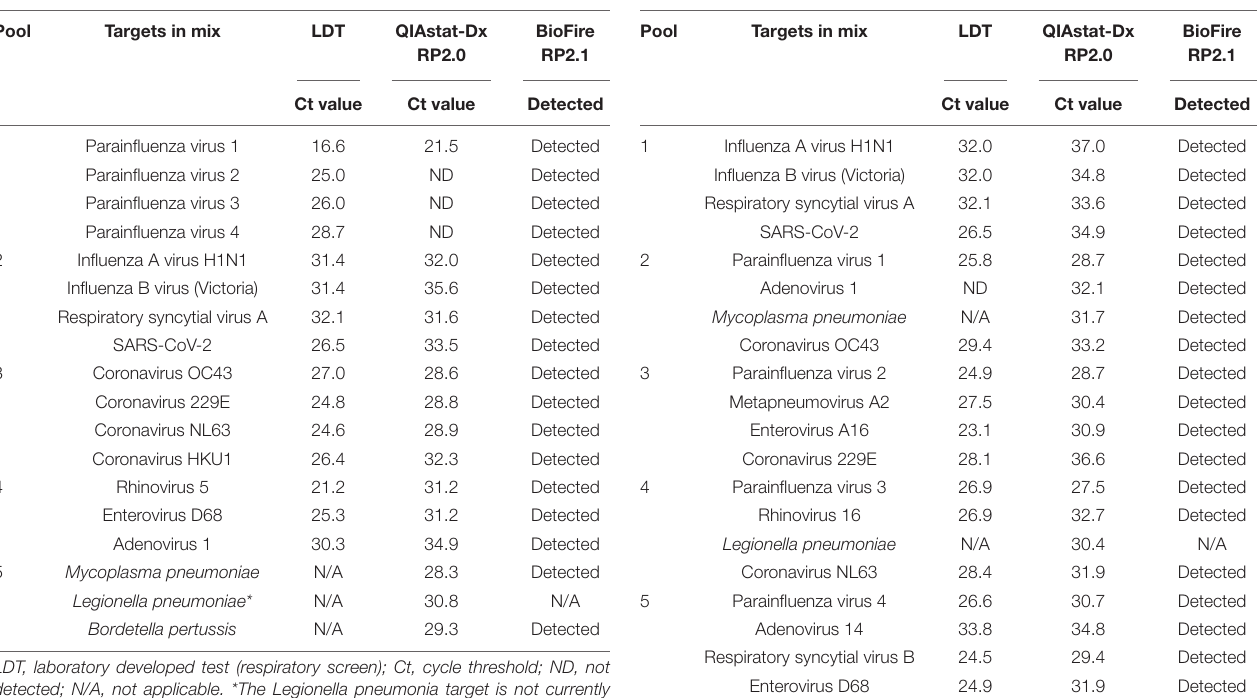
TABLE 2 | Qnostics respiratory panel 1.